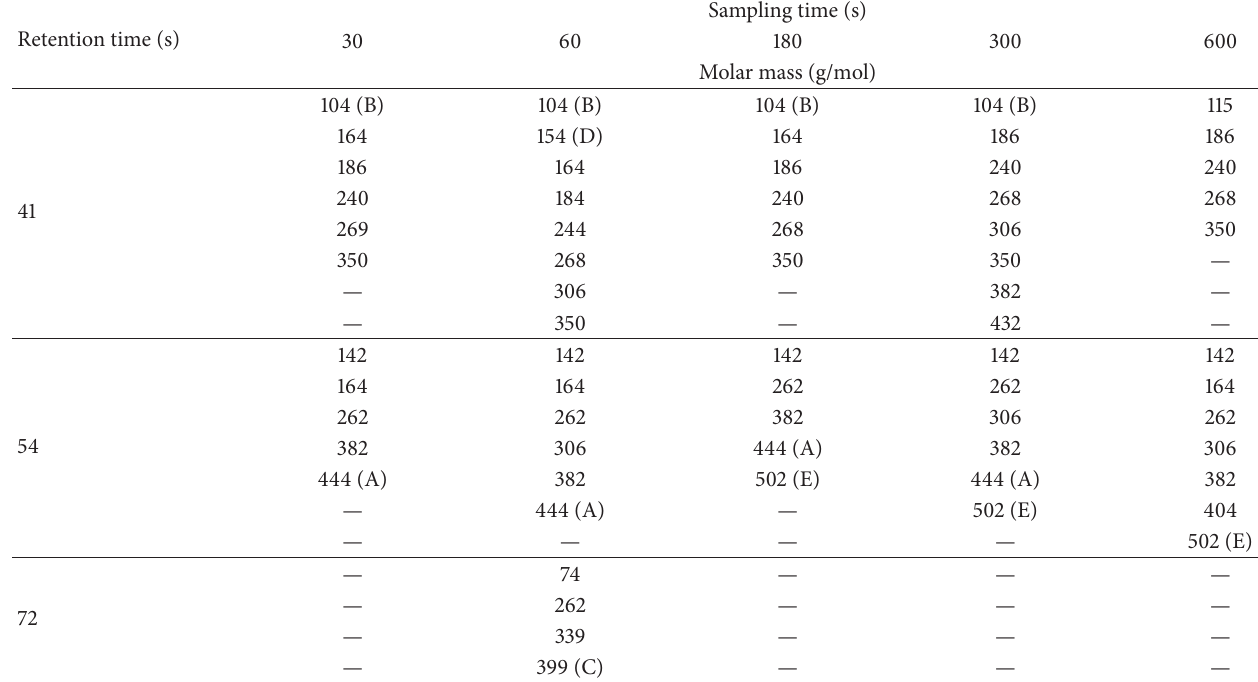
Table 4: Molar masses of the main doxycycline degradation products identified by LCMS-IT-TOF at different sampling times during tests carried out under the best operating conditions identified by the RCCD ( 𝐶 (B–E) main doxycycline degradation